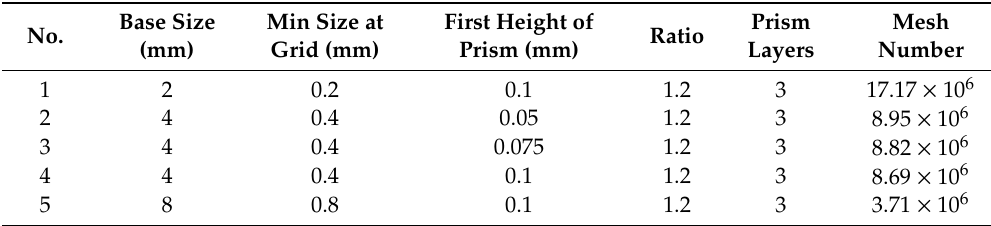
Figure 4. Meshes used for independence verification. ( a ) Mesh1, ( b ) Mesh2, ( c ) Mesh3, ( d ) Mesh4, ( e ) Mesh5. Table 1. Mesh